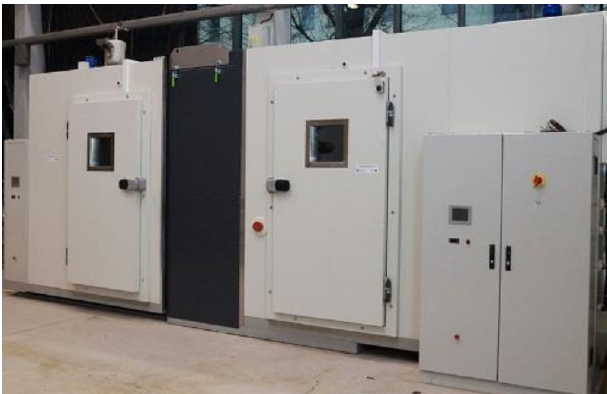
Energies 2023 , 16 , x FOR PEER REVIEW Figure 10. A climatic chamber at the Kielce University of Technology. Figure 10. A climatic chamber at the Kielce University of Technology.